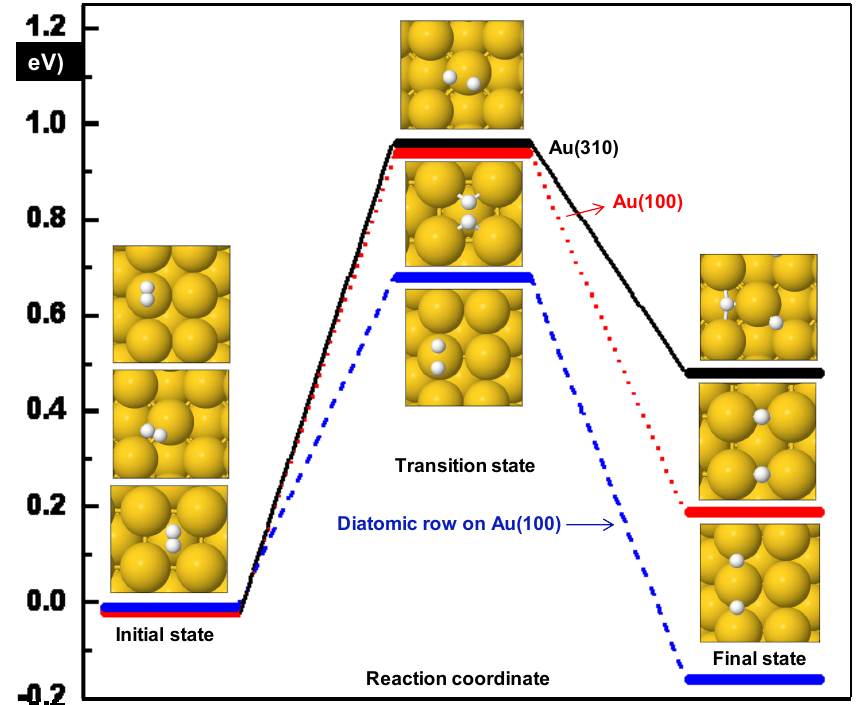
Figure 2. Overview of the results for H offer significantly lower activation